Question: Which kind of chart has been used to present this data?
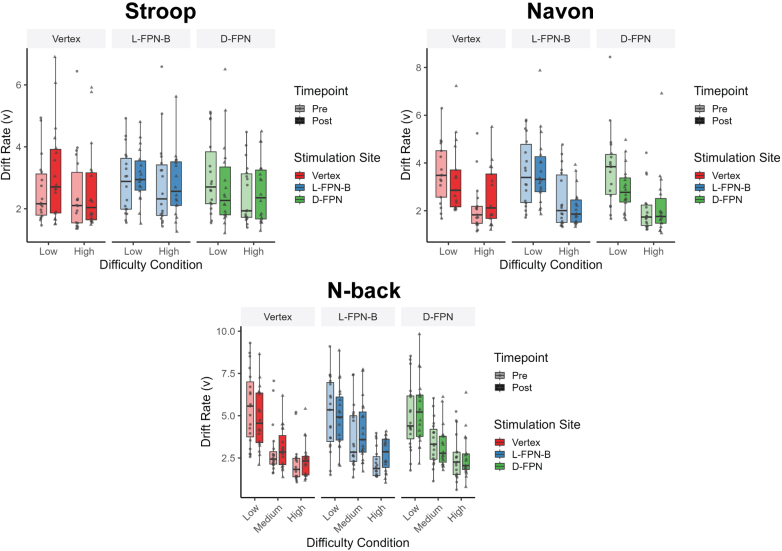
Answer: box